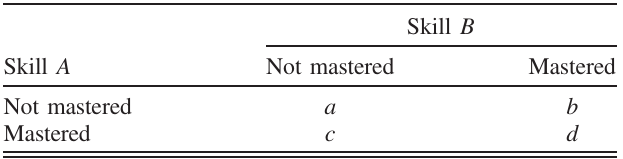
TABLE II. Sample cross tabulation for the mastery of two hypothetical skills. If a ≫ c , d ≫ c , and b ≫ c , then skill A → skill B .